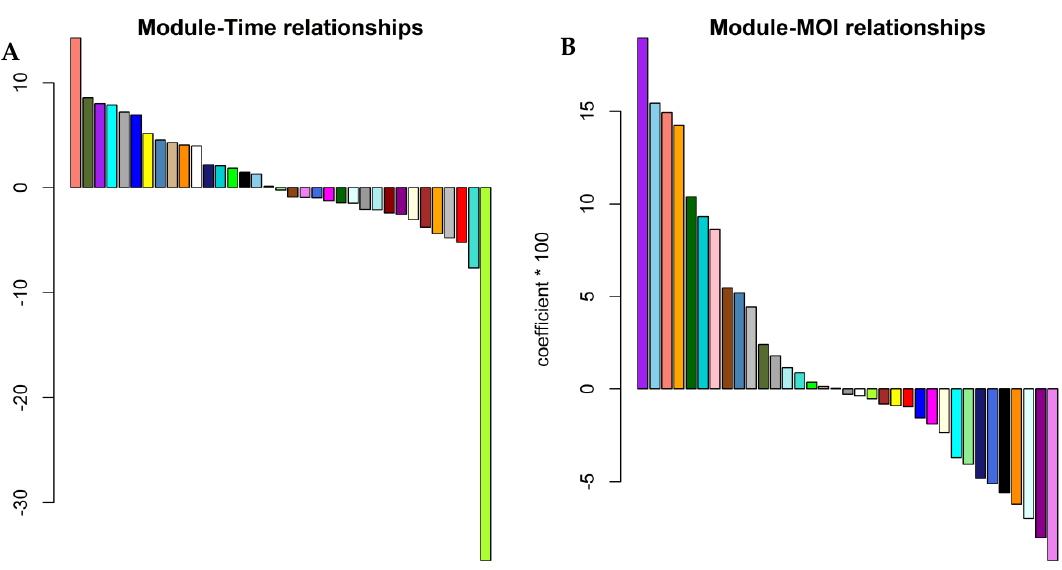
Figure 2. Distribution of module eigengene change in each experiment design of training group.